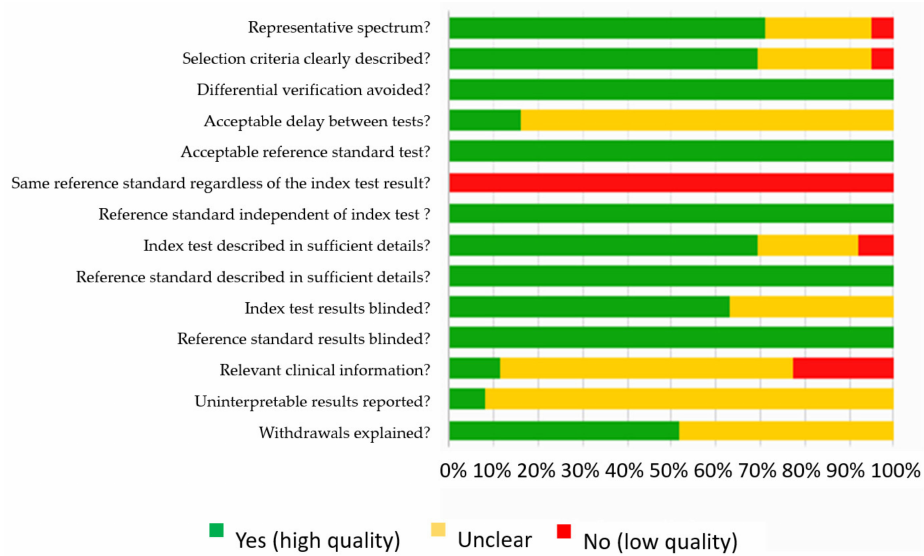
Figure 2. Quality analysis of the included studies based on QUality Assessment of Diagnostic Accuracy Studies